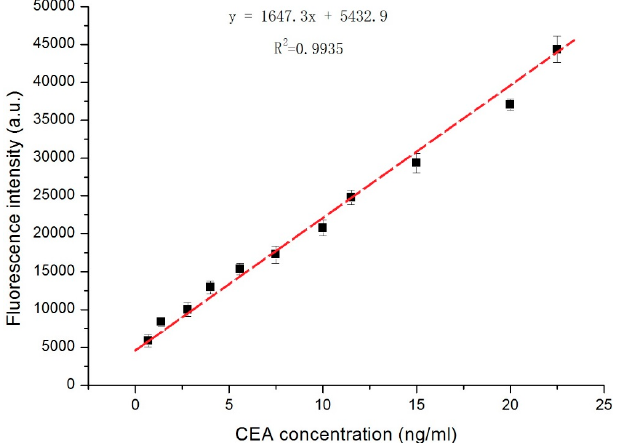
Figure 4. Relationship between fluorescence intensity of aggregated microbeads and CEA concentration in the serum. Table 1. Results from 32 clinical serum